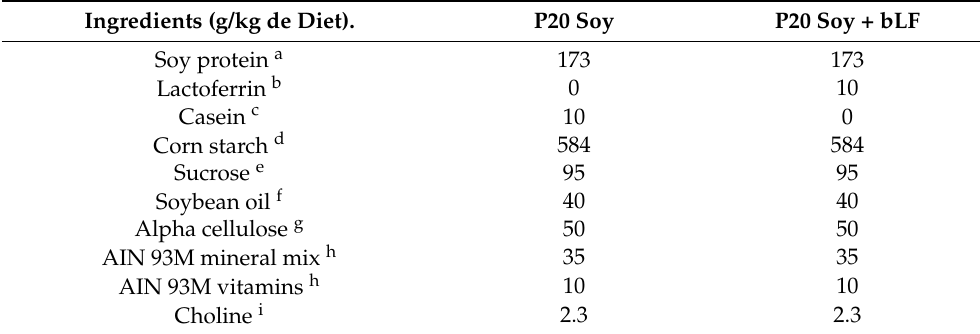
Table 1. Composition of the diets given to the control group of mothers (P20 Soy) or to the bLF- supplemented mothers (P20 Soy + bLF). Ingredients (g/kg de Diet). P20 Soy P20 Soy + bLF Soy protein a 173 173 Lactoferrin b 0 10 Casein c 10 0 Corn starch d